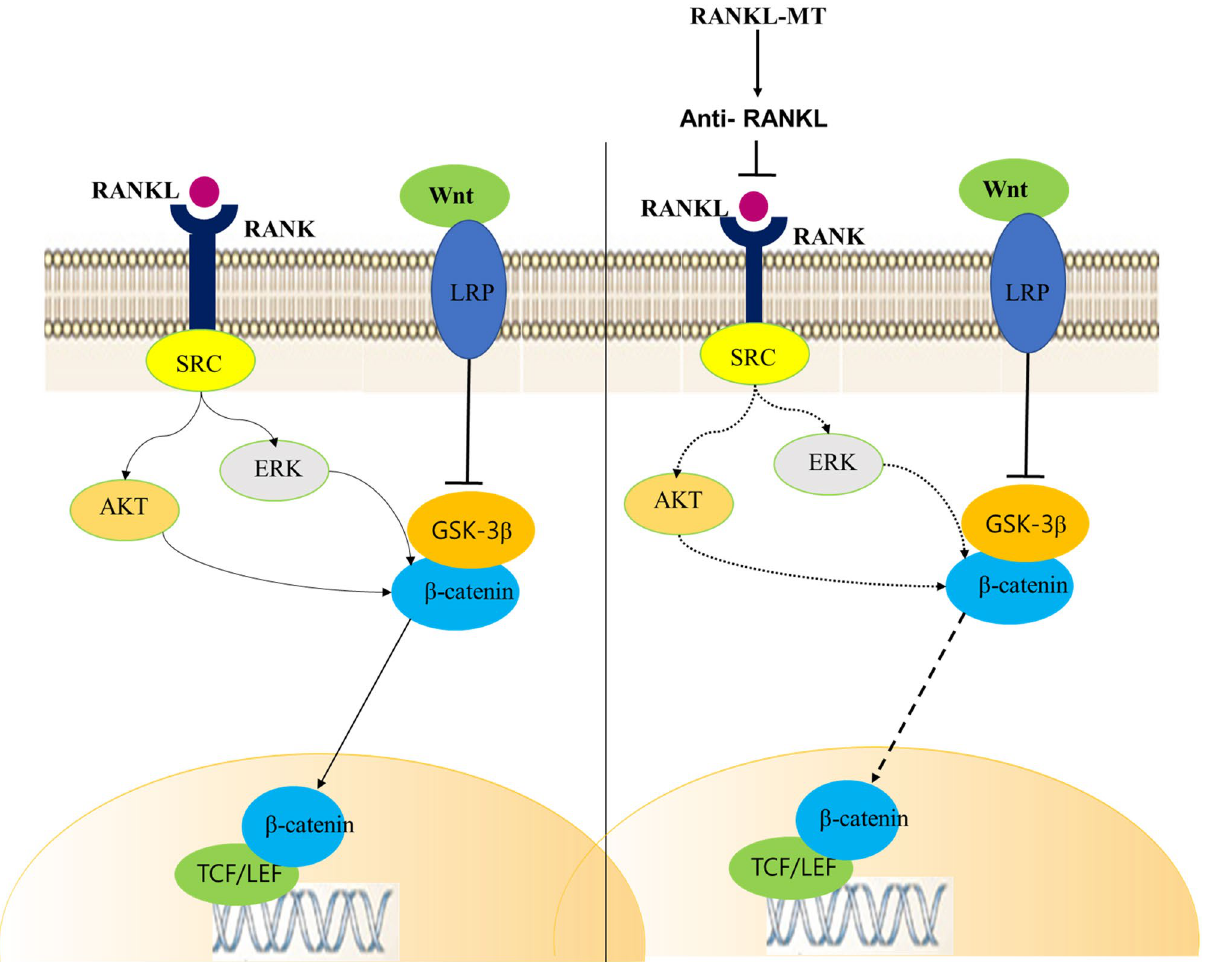
Figure 6. Schematic diagram illustrating anti-RANKL-mediated inhibition of RANK signaling. Activation of RANK by RANKL activates AKT and ERK, thereby liberating the active form of β-catenin. Generation of anti-RANKL antibodies by mRANKL-MT inactivates RANKL, thereby downregulating AKT/ERK activity and preventing downstream of β-catenin